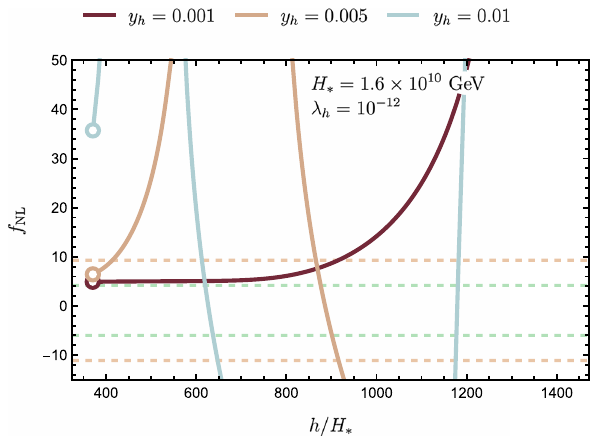
Fig. 5 The dependence of f NL on the Yukawa coupling y h . The green and orange horizontal dashed lines indicate the 1 σ and 2 σ confidence intervals of the Planck data [33],